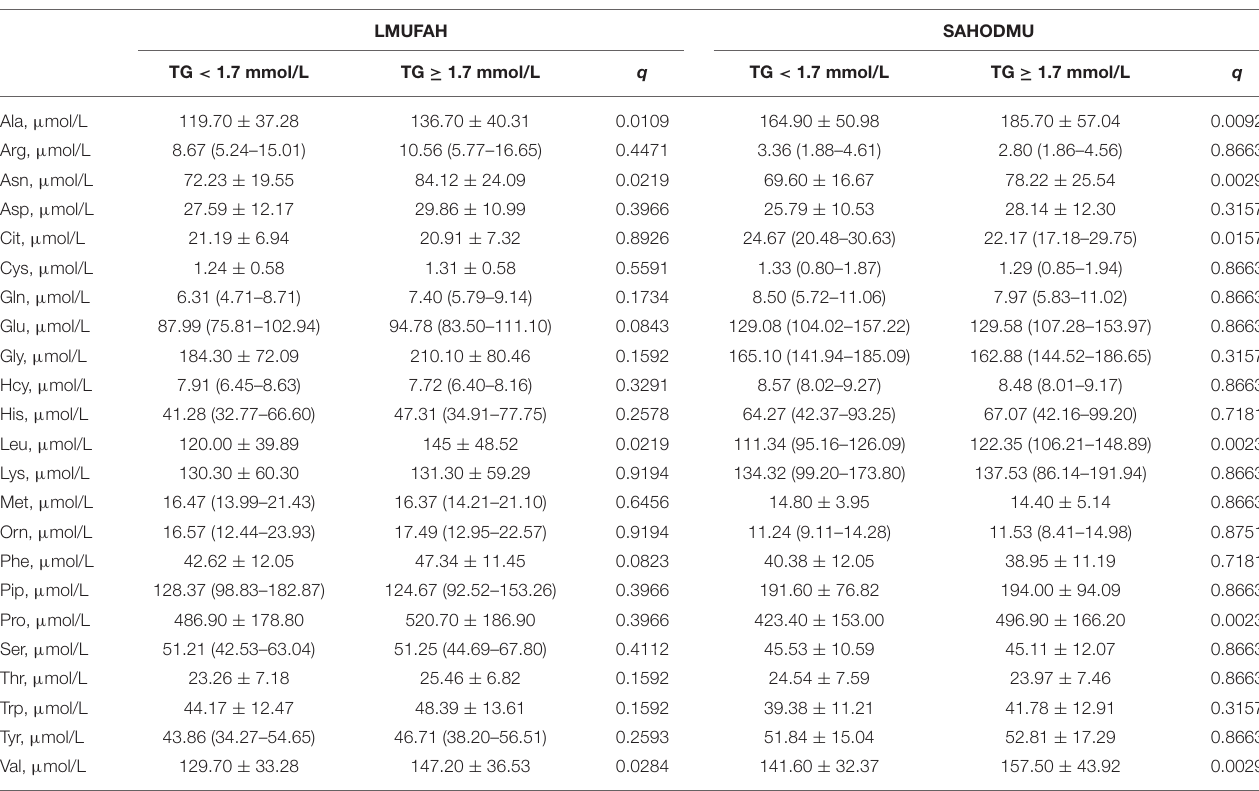
TABLE 2 | Plasma amino acids levels in two cohorts according to TG levels. LMUFAH